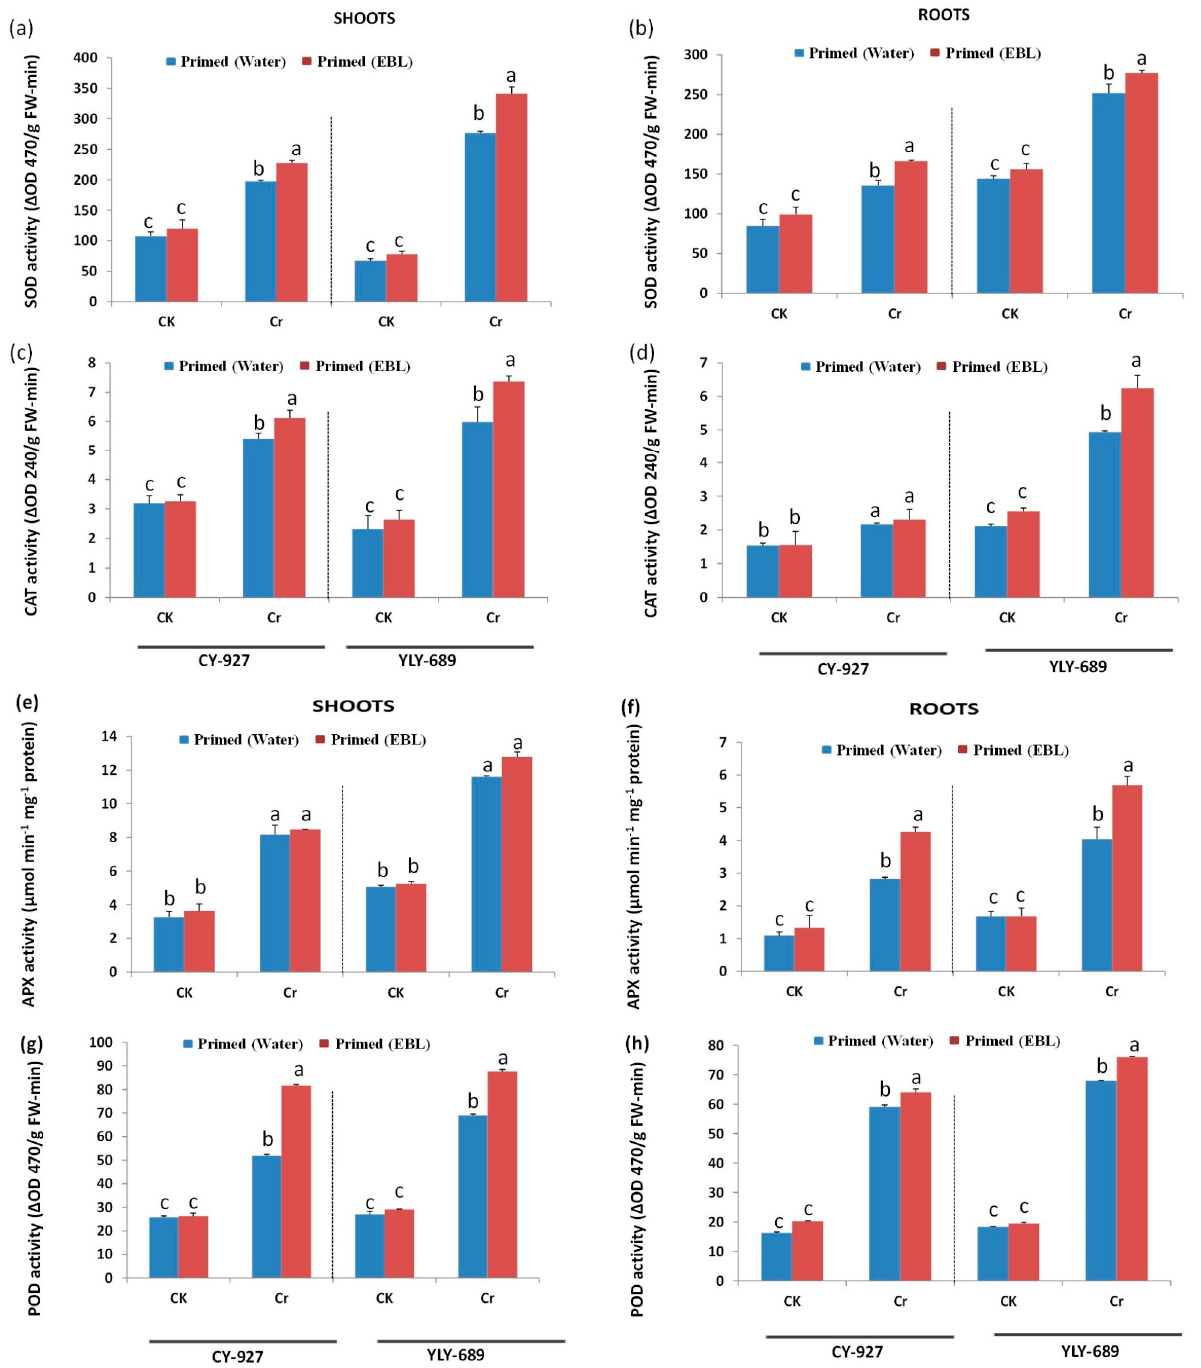
Figure 4. Upregulation of antioxidant enzyme activities by seed priming with EBL under Cr stress in both cultivars. ( a ) and ( b ) superoxide dismutase (SOD) in shoots and roots of both rice cultivars, respectively; ( c , d ) catalase in shoots and roots of both rice cultivars, respectively; ( e , f ) ascorbate peroxidase (APX) in shoots and roots of both rice cultivars, respectively; ( g , h ) peroxidase (POD) in shoots and roots of both rice cultivars, respectively. The values presented are means ± SDs ( n = 3). Different letters (a–c) above bars show a significant difference at p < 0.05 among treatments.